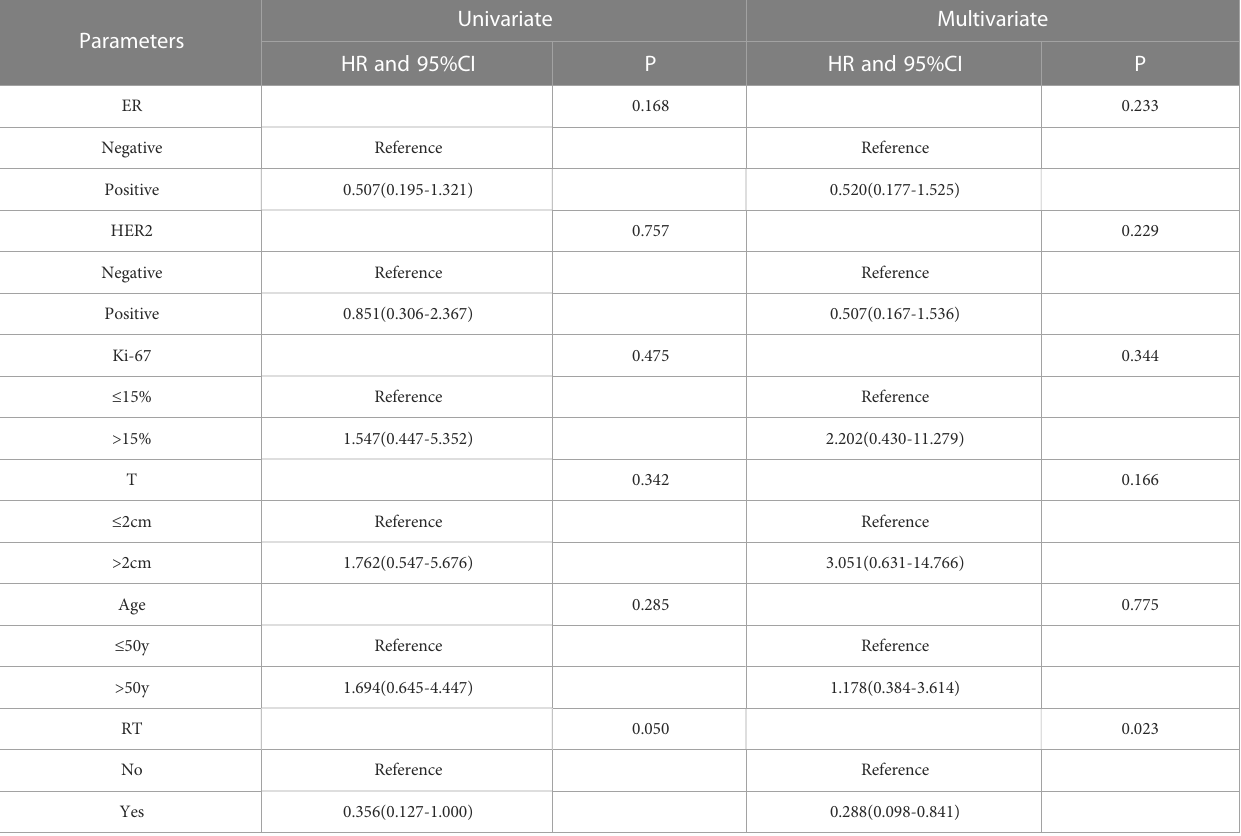
TABLE 3 Results of the univariate and multivariate analysis of DFS and clinicopathological characteristics in post-mastectomy pre-cN+/ypN0 patients (n=142).